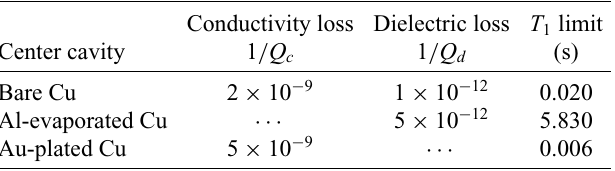
TABLE I. Comparison of qubit losses induced by different cas- ing materials for the presented package geometry. The values are obtained with EM simulations of a ν = 5 GHz transmon qubit. The qubit is located in the corner of a 5 × 5 mm 2 chip to estimate the maximum impact of package material induced losses. The T 1 limit is estimated as 1 /( 1 / Q c + 1 / Q d ) [1 /( 2 πν) ]. tics: copper (Cu), conductivity of 5 × 10 10 S m [24] and an